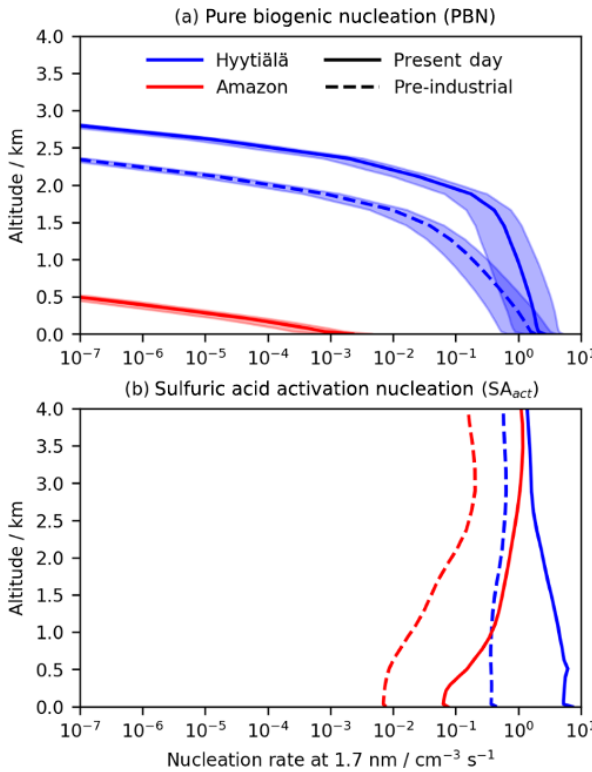
Figure 8. PD and PI modelled nucleation rates averaged over June for (a) summed (neutral + ion-induced) pure biogenic nucle- ation (assumes altitude-independent ion production rate – IPR – of 2cm − 3 s − 1 ; Hirsiko et al., 2011; shading shows IPR variation of 0.5–5cm − 3 s − 1 ) and (b) nucleation from sulfuric acid only (SA act ). Both mechanisms are predicted to produce greater nucleation rates in the PD due to greater concentrations of precursor species. Im- portantly however, PBN at low altitude at Hyytiälä is predicted to be comparable to SA nucleation in the PI period due to the greater modelled ion concentration arising from a lower condensation sink and reduction in rates from SA act due to lower sulfuric acid concen- trations. This leads to a larger increase in the total nucleation rate in the PI period than in the PD with potential implications for PI aerosol burden and